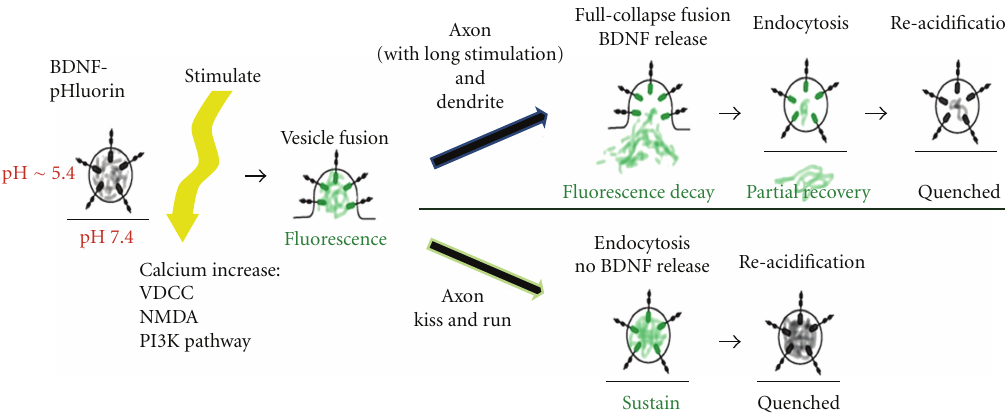
Figure 2: Schematic illustration of how BDNF-pHluorin fluoresces, both inside the vesicle and upon axonal and dendritic vesicular fusion. Before stimulation, BDNF-pHluorin protein shows little fluorescence. If intracellular calcium increase occurs upon electrical stimulation, then BDNF-pHluorin vesicle may fuse, opening up to the pH 7.4 extracellular space, causing a transient spike in fluorescence that can be detected by TIRF microscopy. Di ff erent styles of fusion between axon and dendrite are shown, as explained in [10] and in the text. After sustained vesicular fusion as occurs in dendrites, fluorescence will decrease as a result of BDNF-pHluorin di ff usion out of vesicles. Kiss-and- run fusion as occurs in stimulated axons will rather show an increase in fluorescence because minimal pHluorin di ff uses out of the vesicle. The sticks represent synaptotagmin-4; see [85] for details. Modified from Figure 4(e) in [85].